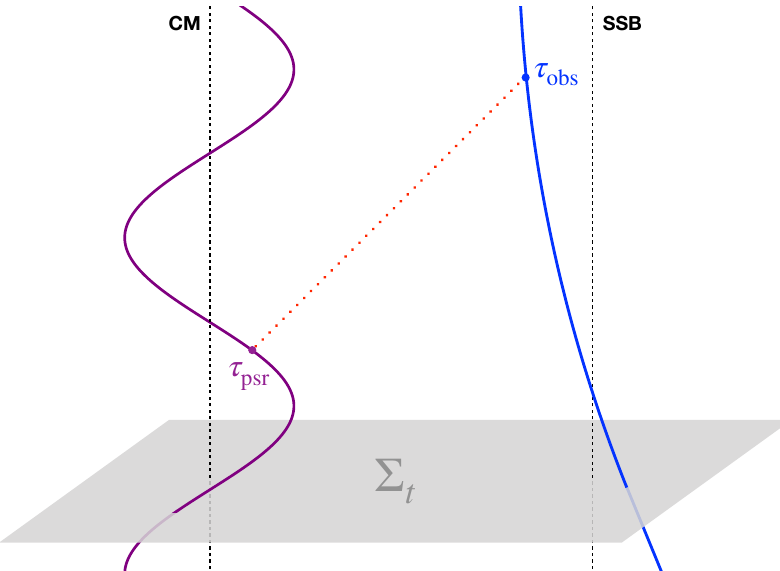
Figure 2. Spacetime view of pulsar timing. The null-geodesic of the radio signal (red dotted line) connects the world line of the pulsar (purple) with that of the observer (blue). The pulsar moves around the center of mass of the binary system (“CM”), while the observer moves around the barycenter of the Solar System (“SSB”). The signal gets emitted at the pulsar’s proper time τ psr and arrives at the radio telescope at the observer’s proper time τ obs . Σ t depicts a hypersurface of constant (coordinate) time t